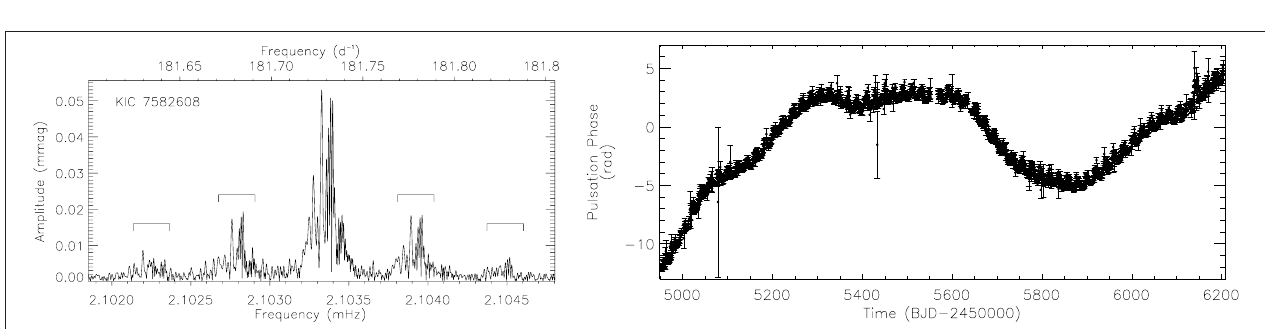
FIGURE 2 | (Left) Amplitude spectrum of the LC 4-year light curve of KIC7582608 showing the “ragged” structure discussed in the text. The five broad peaks, the central peak and those under the brackets, are split by the rotation frequency of the star (0.566 µ Hz, P = 20.4499d), indicating a quadrupole mode. (Right) Phase variation of the pulsation mode indicating significant frequency variability in this